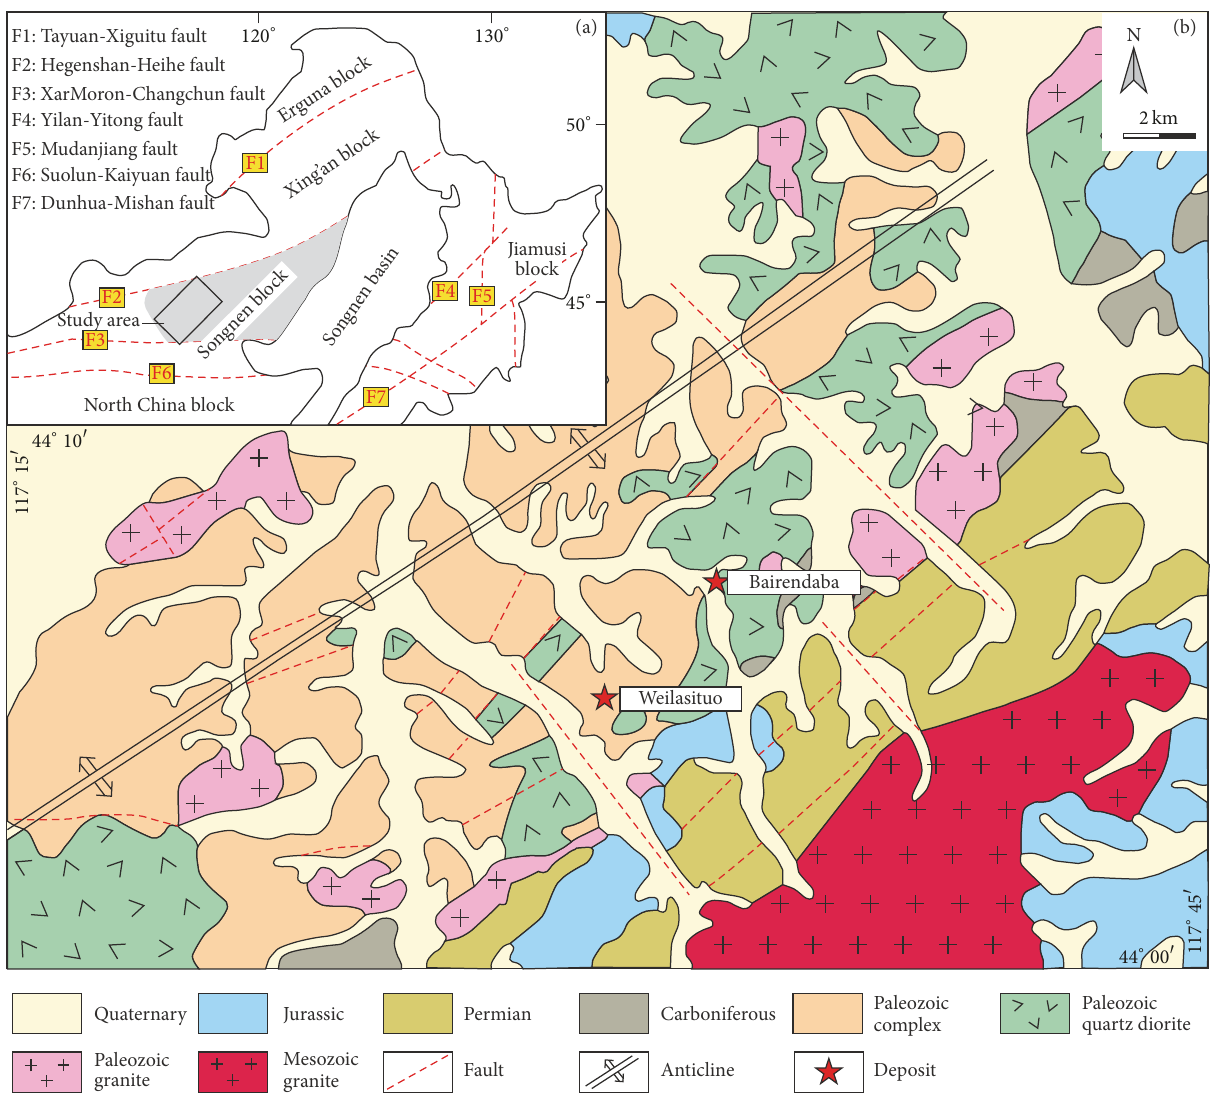
Figure 1: (a) Tectonic map of northeastern China [29]. (b) Regional geological map of the Bairendaba district [30].